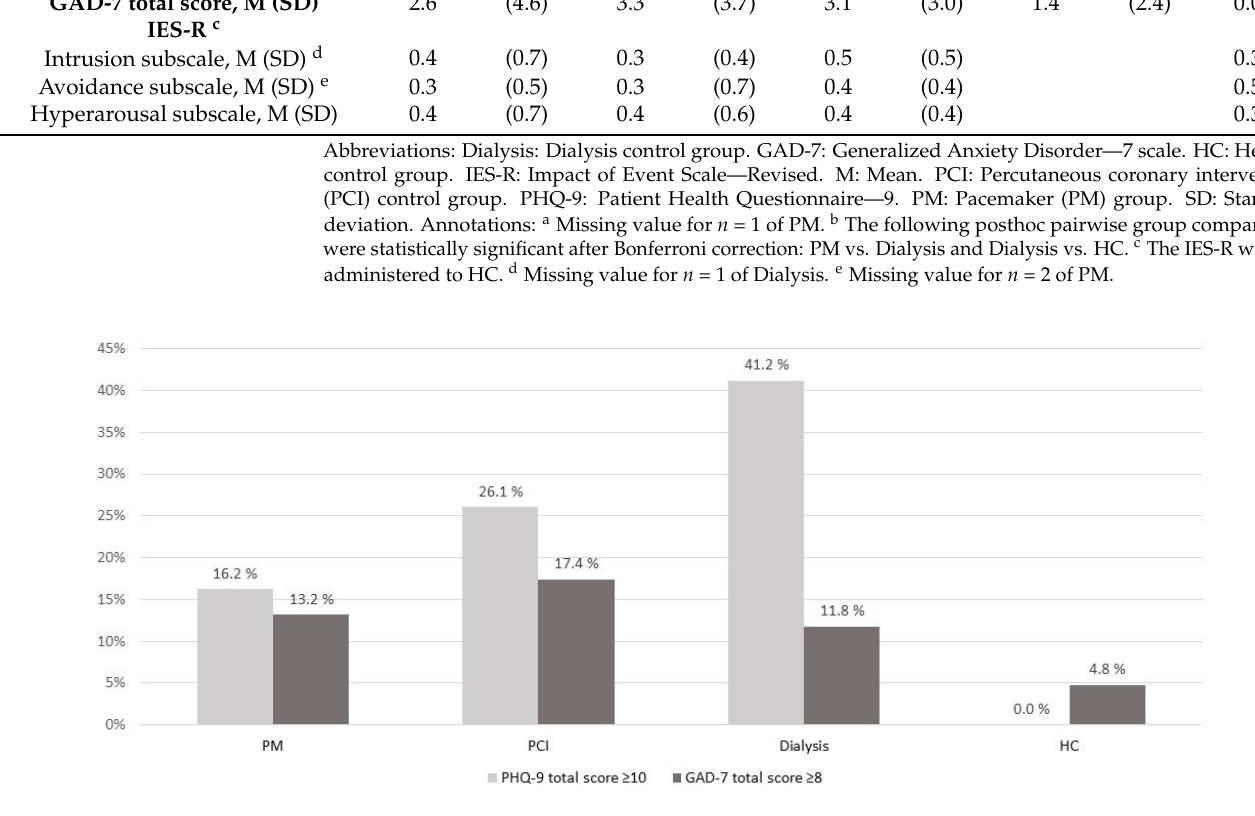
Figure 2. Proportion of participants with self-report of clinically significant depression and anxiety. Clinically significant depression is defined as PHQ-9 total score ≥ 10. Clinically significant anxiety is defined as GAD-7 total score ≥ 8. Clinically significant depression: p < 0.001 across study groups with the following statistically significant posthoc pairwise group comparisons after Bonferroni correction: PM vs. HC, PCI vs. HC, and Dialysis vs. HC. Clinically significant anxiety: p = 0.36 across